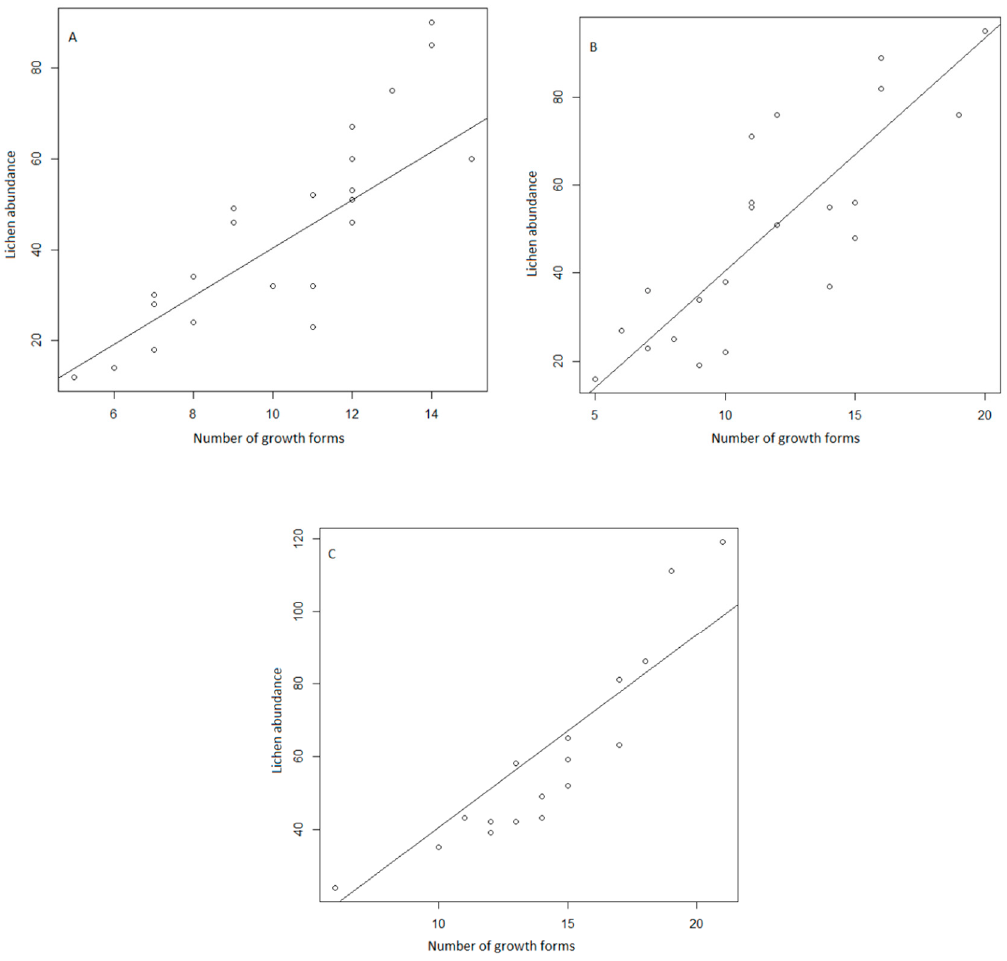
Figure 2. Results of the linear models based on the number of growth forms (x-axis) and epiphytic species abundance (y-axis) in European forests for: ( A ) Coniferous forests ( y = 6.681x − 23.732, n = 22, R 2 = 0.719) , ( B ) Oak forests ( y = 4.839x − 7.124, n = 22, R 2 = 0.679) , and ( C ) Beech forests ( y = 6.597x − 34.437, n = 17, R 2 = 0.827); p < 0.0001 in all cases.